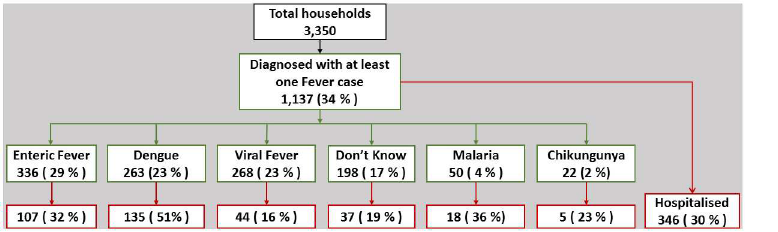
Fig 2. Pathology of respondents diagnosed with